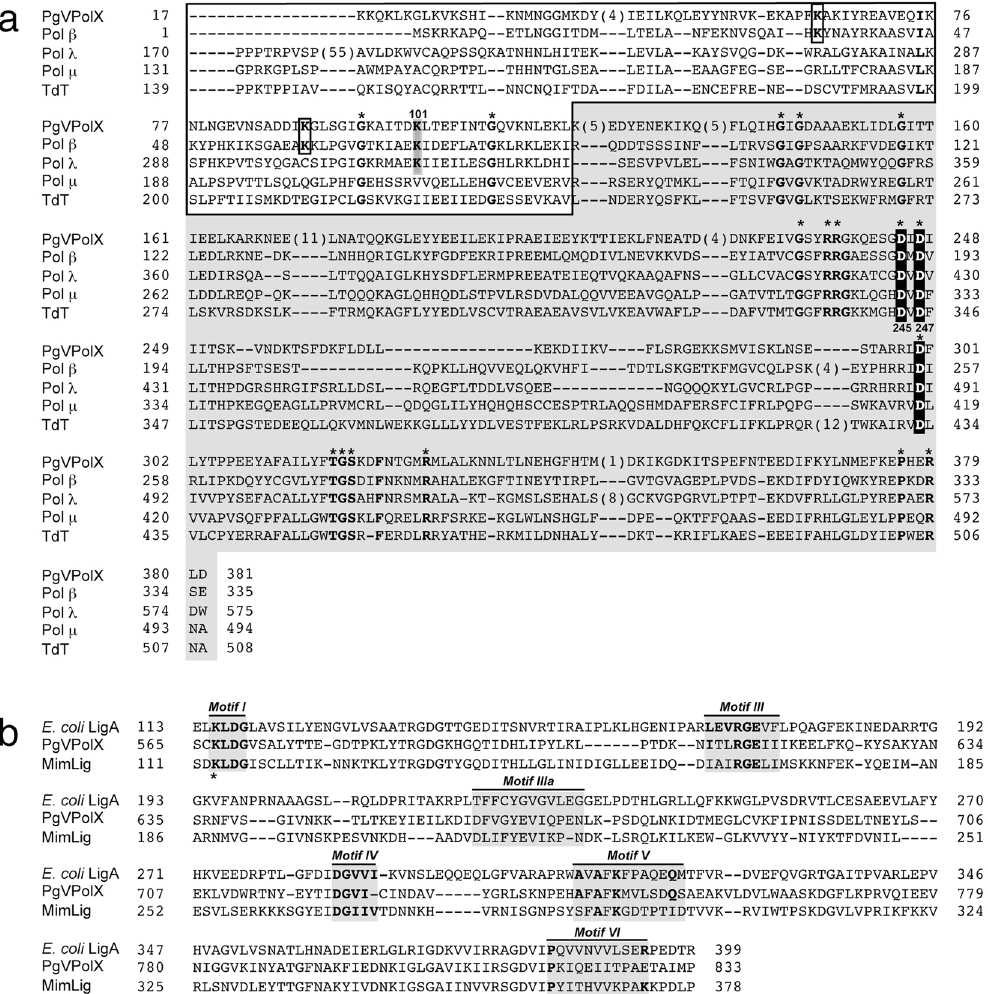
Figure 1. ( a) Multiple sequence alignment of the Pol β -like core of PgVPolX with human family X DNA polymerases. Numbers indicate the amino acid position relative to the N-terminus of each DNA polymerase. Names of organisms are abbreviated as follows (numbers in parentheses indicate the corresponding accession number): PgV-16T PolX, DNA polymerase X from strain 16 T of P. globosa virus (NC_021312.1); Pol β , human DNA polymerase β (NP_002681); Pol λ , human DNA polymerase λ (NP_037406); Pol μ , human DNA polymerase μ (NP_001271260.1); TdT, terminal deoxynucleotidyl transferase (NP_001017520.1). White letters boxed in black indicate the three conserved Asp responsible for the polymerization reaction. Black bold letters boxed in gray indicate the nucleophile residue responsible for the 5 ′ -dRP lyase activity in Pol β and Pol λ . Black bold letters boxed in white indicate the other two lysine residues described to play a role in 5 ′ -dRP lyase catalysis in Pol β . Asterisks indicate invariant residues among PolX members 11 . According to Pol β structural data 17, 60 , the alignment is divided into the 8-kDa subdomain (white area), and the polymerization domain (grey area). (b) Alignment of the C-terminal NAD + -dependent DNA ligase domain of PgVPolX with the Ligase A from E. coli and Mimivirus DNA Ligase (MimLig) . The conserved Motifs I-VI present in NAD + -dependent DNA ligases are indicated 61 . An asterisk indicates the lysine residue that is specifically adenylated during the ligation reaction. The accession numbers of E. coli LigA and MimLig are WP_001413640.1 and Q5UPZ0.1,